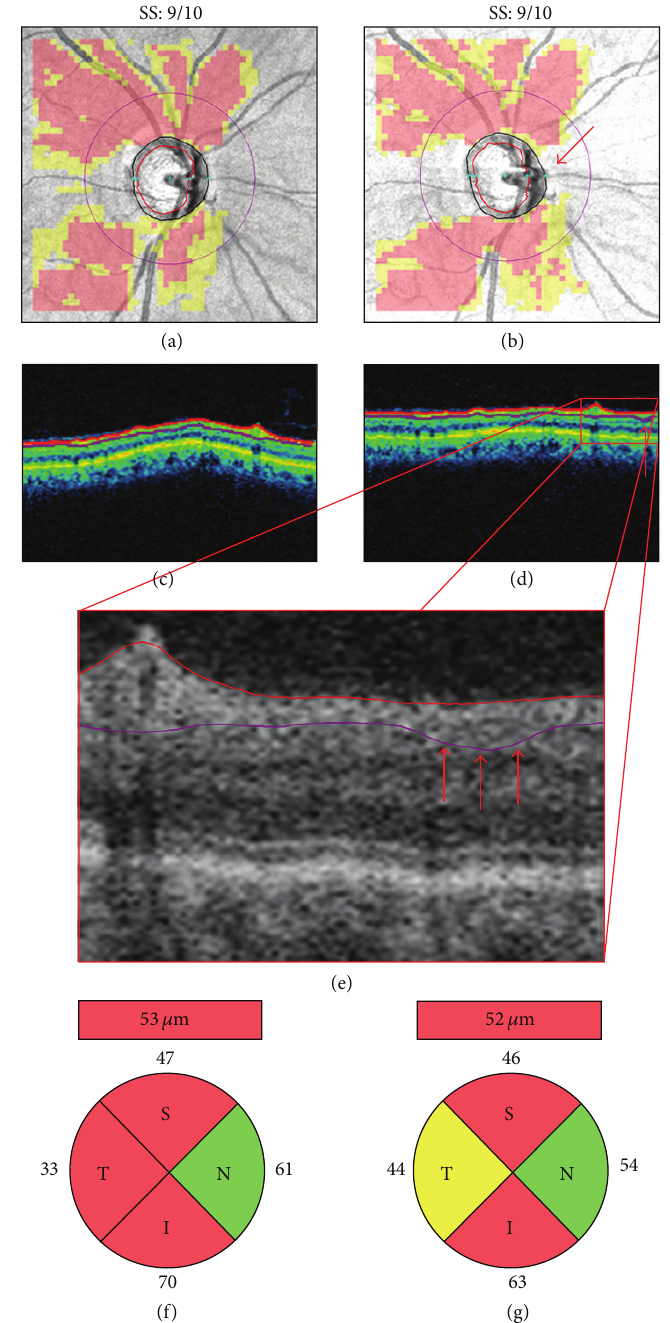
Figure 10: Inaccurate retinal nerve fiber layer (RNFL) segmentation. Pair of right optic disc scans collected on the same day ((a)-(b)). The second scan presents with a motion artifact intersecting the temporal and nasal quadrants of the scan circle ((b) arrow), which is likely responsible for the subtle RNFL segmentation error ((d)-(e), arrows) and the resulting temporal RNFL thickening with classification change ((f)-(g)). SS: signal